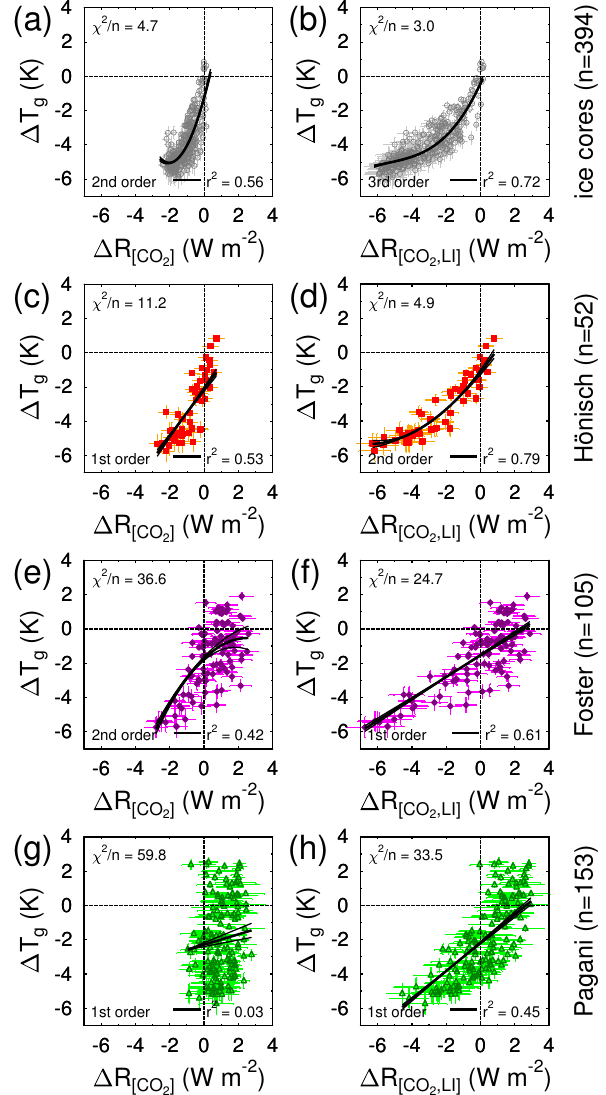
Figure 7. Scatter plots of data of global temperature change, (cid:49)T g , against radiative forcing (cid:49)R [ X ] . (cid:49)T g is calculated with the po- lar amplification factor, f pa , being a linear function of (cid:49)T NH . Left column (a,c,e,g) : radiative forcing of CO 2 ( (cid:49)R [ CO ). Right 2 ] column (b,d,f,h) : radiative forcing of CO 2 and land ice albedo ( (cid:49)R [ CO ). Lines show average best fits (first-, second-, or third- 2 ,LI ] order polynomials) to 5000 Monte Carlo realizations of the data (de- tails in Table 1). Subfigures differ by the CO 2 data they are based on: (a,b) – ice cores (Bereiter et al., 2015); (c,d) – δ 11 B from the Hönisch lab (Hönisch et al., 2009); (e,f) – δ 11 B from the Foster lab (Foster, 2008; Martínez-Botí et al., 2015); (g,h) – alkenones from the Pagani lab (Pagani et al., 2010; Zhang et al., 2013). Each row contains information on the number of data points n ; each subfigure shows the mean uncertainty of the fit by dividing χ 2 (the weighted sum of squares from the regression analysis) by n and the correla- tion coefficient r 2 . Uncertainties show 1 σ